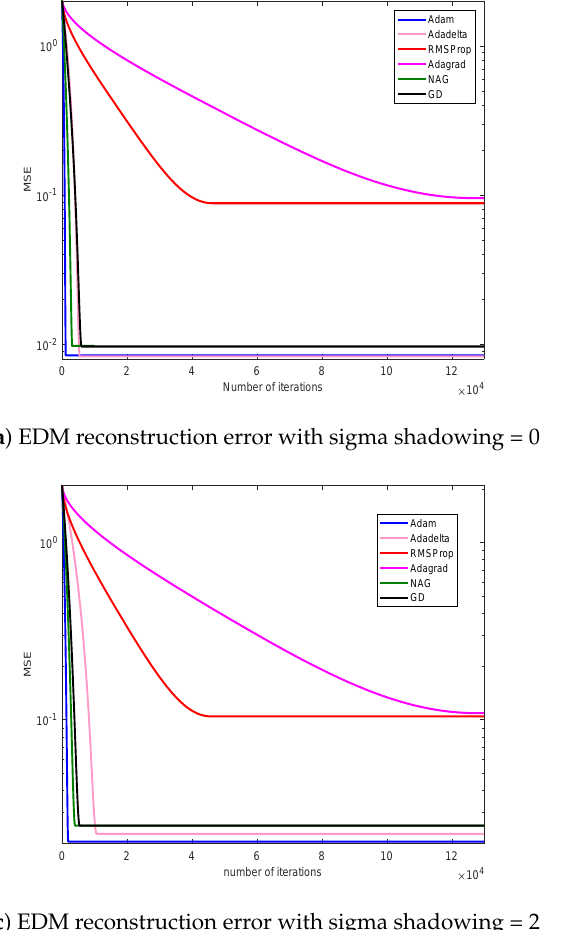
( d ) Localization error with sigma shadowing = 2